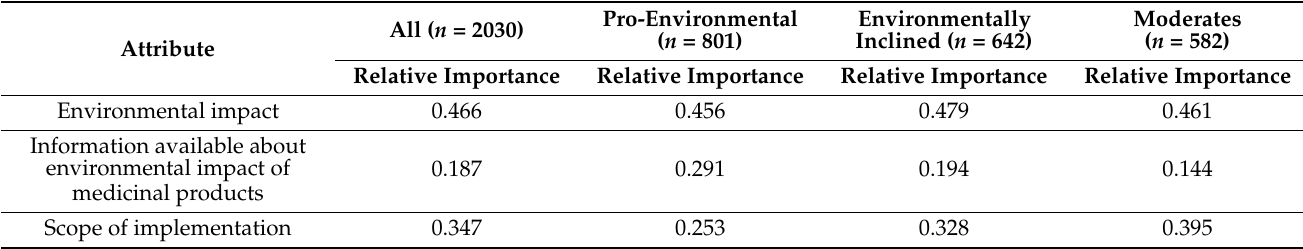
Table 5. The relative importance of attributes perceived by the respondents and latent classes.